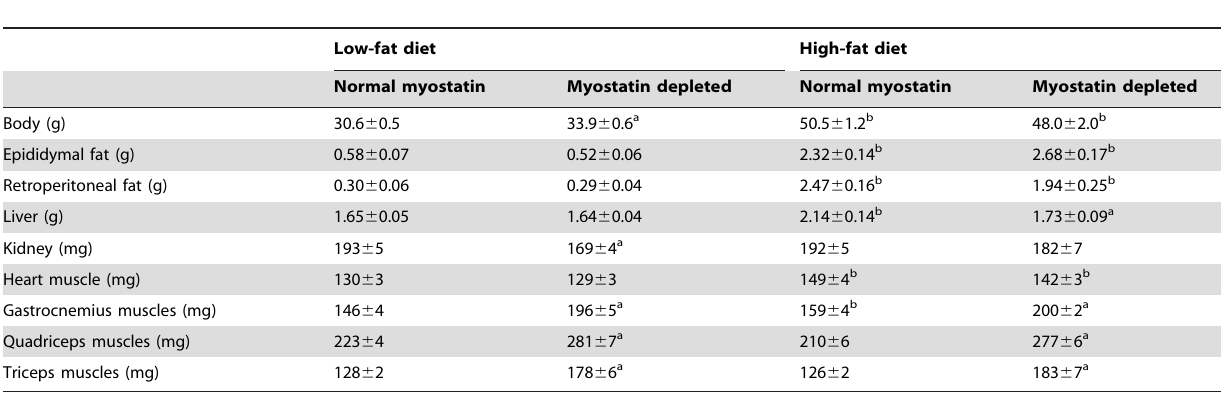
Table 1. Effects of myostatin depletion and high-fat feeding on body and organ mass.